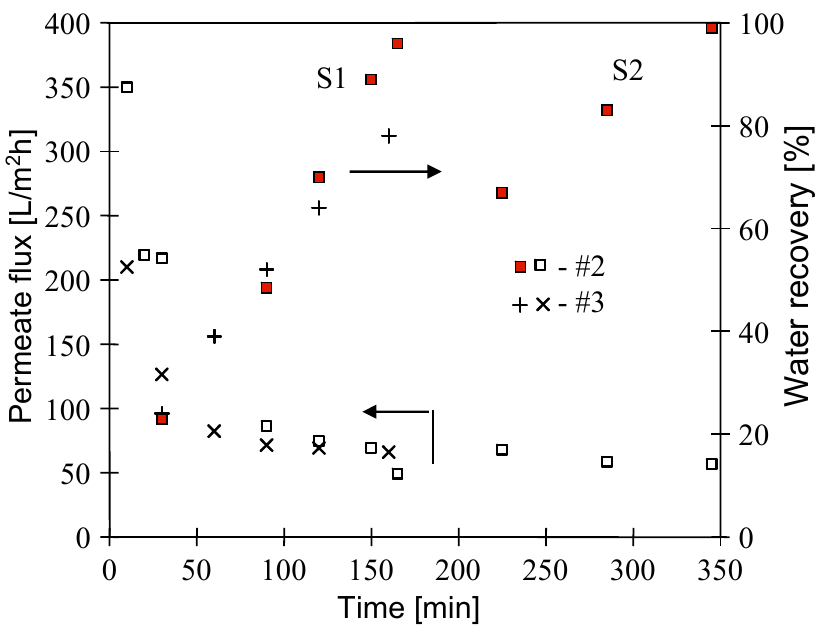
Figure 17. Changes in permeate flux and water recovery coefficient during MF of real wastewaters #2 and #3. Module MF2, TMP = 0.05 MPa, v F = 0.5 m/s, T = 22 °C.